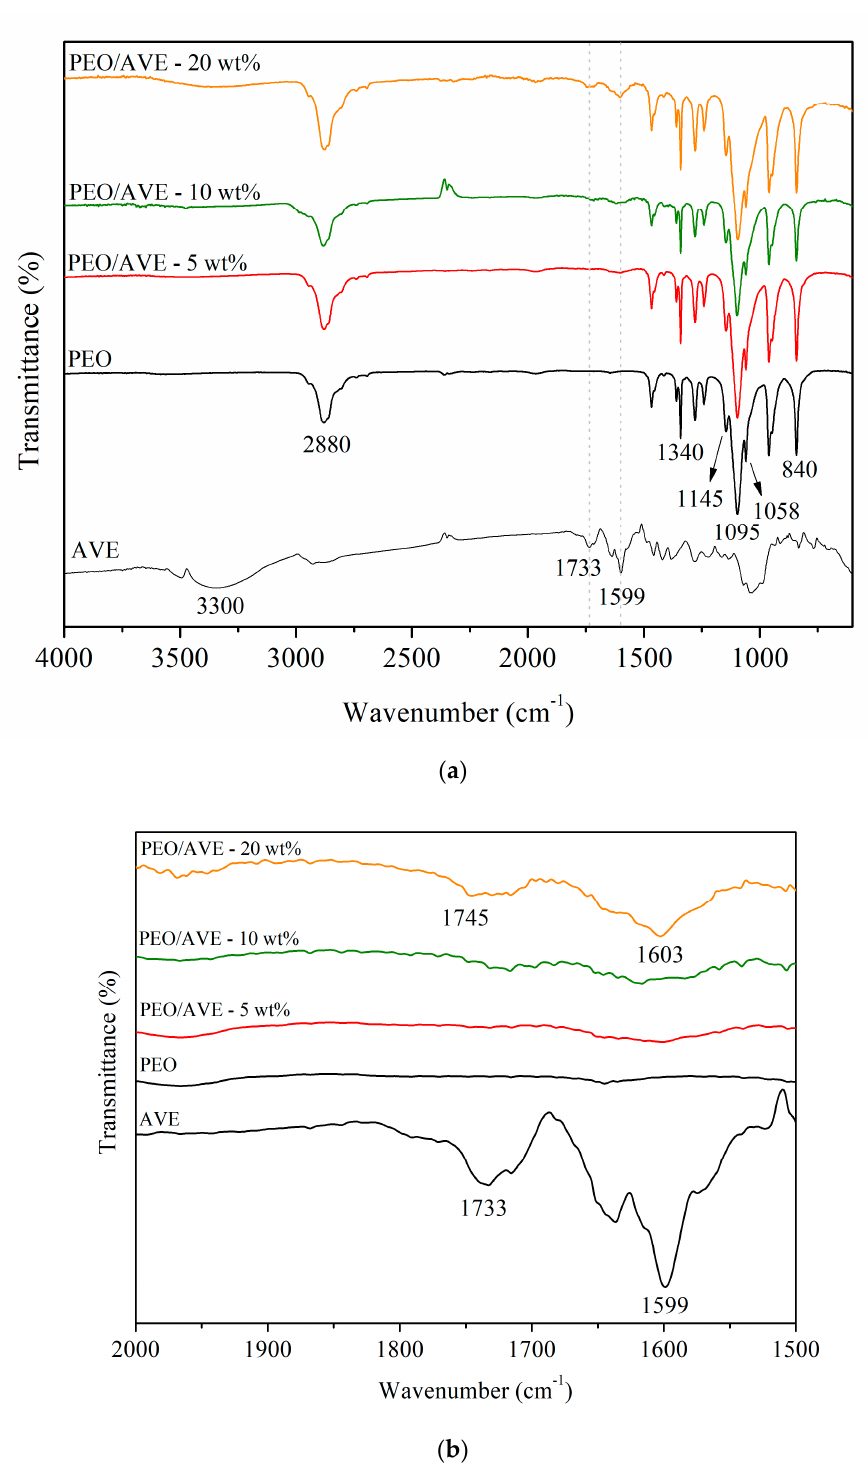
Figure 2. FTIR spectra of AVE, and PEO and PEO/AVE nanofibers. ( a ) from 4000 to 600 cm − 1 ( b ) zoom region from 2000 to 1500 cm − 1 .